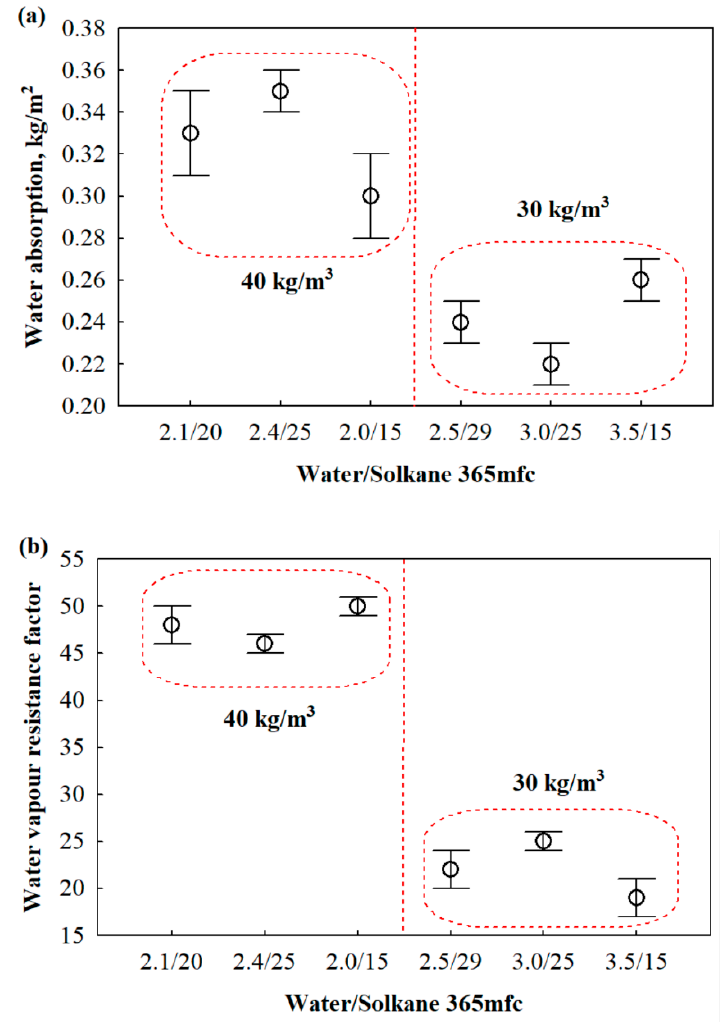
Figure 6. Moisture properties of rigid polyurethane foam: ( a ) short-term water absorption and ( b ) water vapor resistance factor.